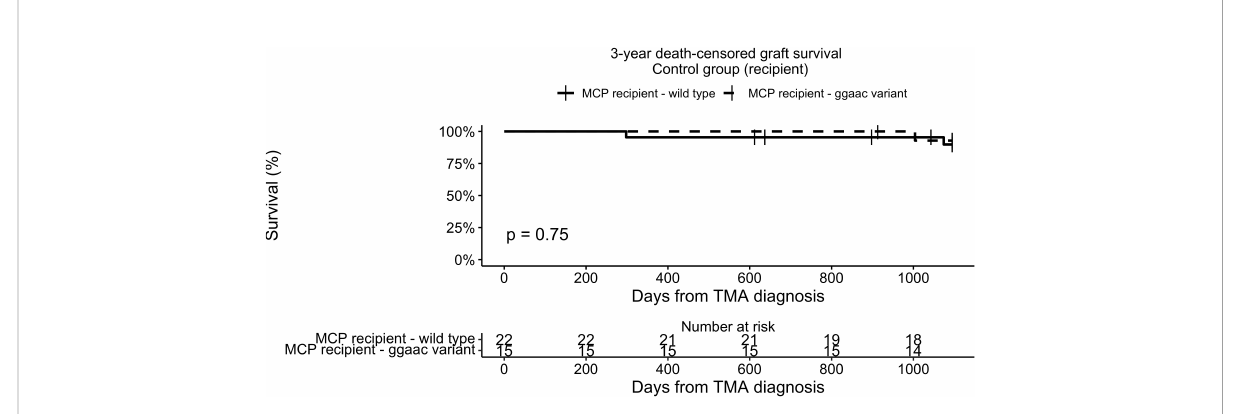
FIGURE 4 3-year death-censored graft survival in the control group according to recipient